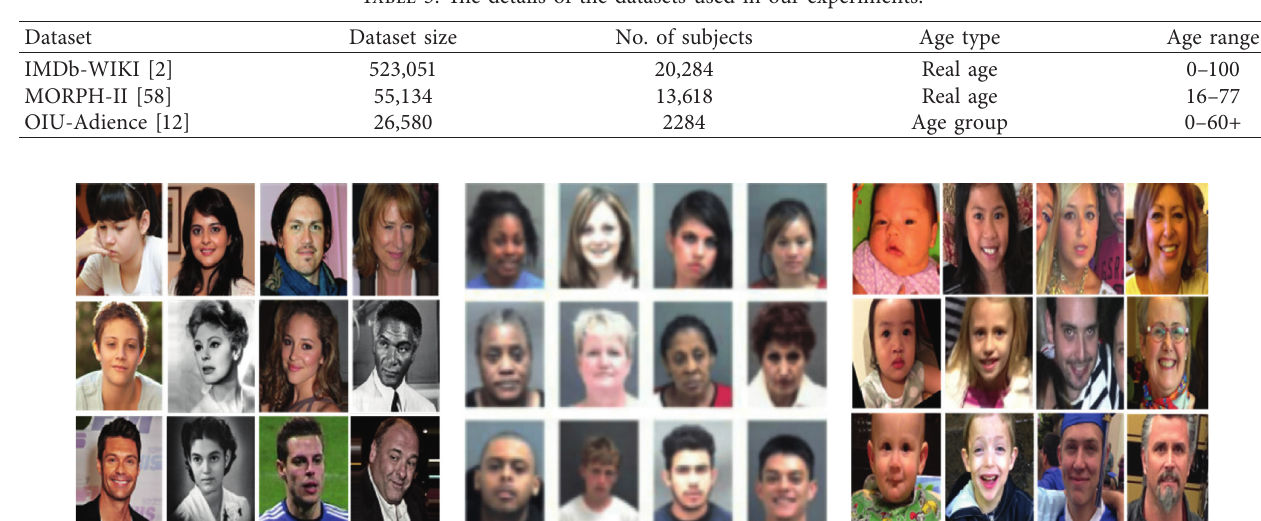
Figure 3: Sample face images from IMDb-WIKI, MORPH-II, and OIU-Adience datasets.